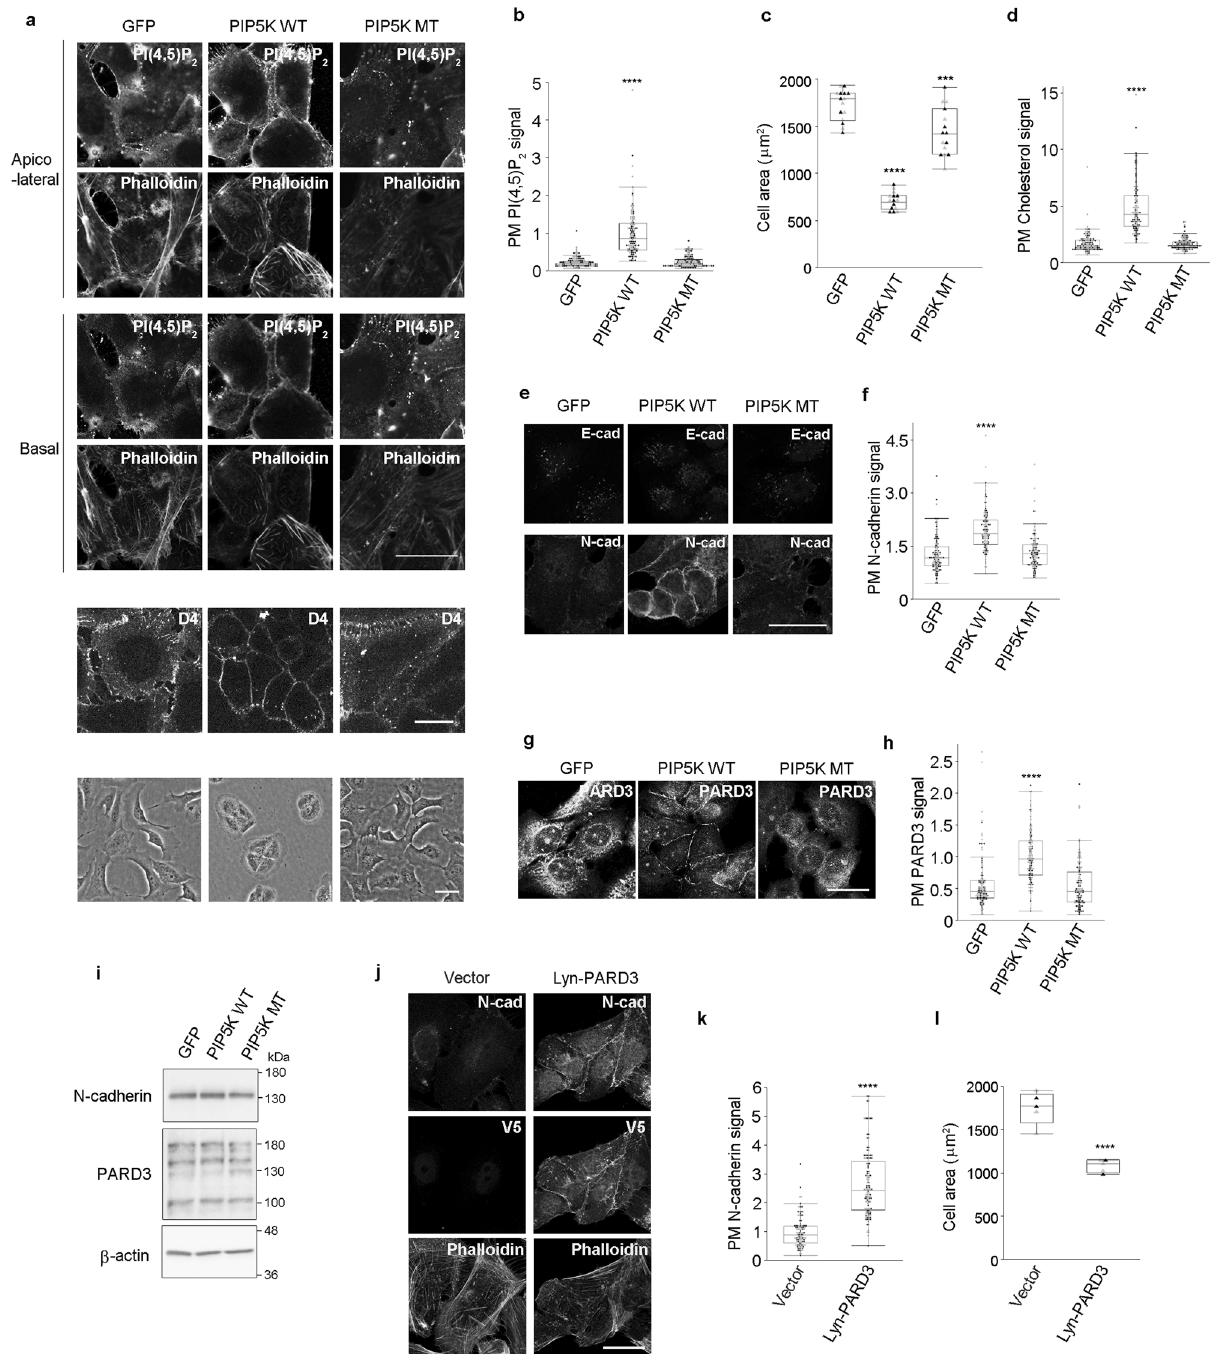
dissolved in methanol for LC/MS/MS measurements of PC. PIPs were measured as described previously 44 . To analyze acidic phospholipids, such as PI and PIP, another aliquot of the same lipid extract was added to an equal volume of methanol before being loaded onto a diethylaminoethyl-cellulose column (Santa Cruz Bio- technology, Santa Cruz, CA, USA) pre-equilibrated with chloroform. After suc- cessive washes with chloroform/methanol (1:1, v/v), the acidic phospholipids were eluted with chloroform/methanol/HCl/water (12:12:1:1, v/v), followed by eva- poration to dryness to give a residue, which was resolved in methanol. The resultant fraction was subjected to methylation with TMS-diazomethane before LC/MS/MS analysis 45 . LC-MS/MS analysis was performed using an UltiMate 3000 LC system (Thermo Fisher Scienti fi c) equipped with an HTC PAL autosampler (CTC Analytics, Zwingen, Switzerland). The lipids were separated on a